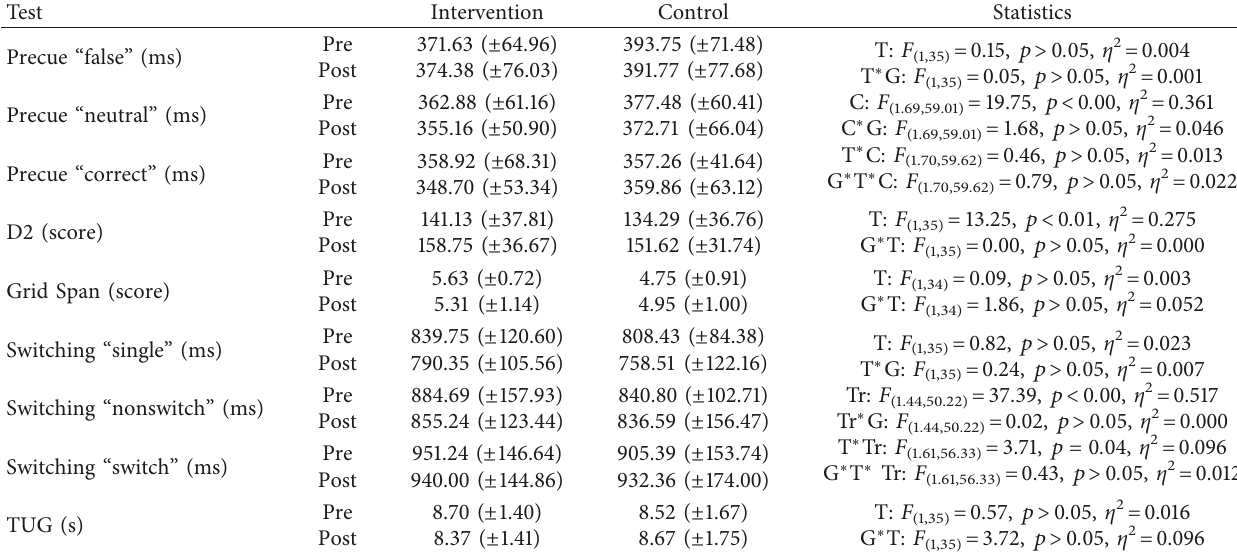
Figure 3: Response accuracy in the Attention Window test, plotted separately for the three axes and for the intervention group and the control group. Boxes indicate across-participant means and error bars the pertinent standard errors. (a) Diagonal. (b) Horizontal. (c) Vertical. Table 2: Mean values and standard deviation of pre- and posttest scores in the intervention and control group as well as statistical results (T time, C cue, G group, Tr (cid:31) (cid:31) (cid:31) (cid:31)